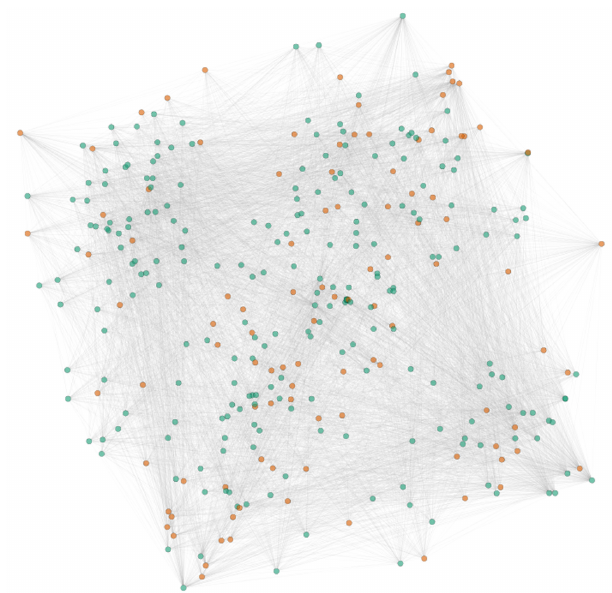
Figure 7. Integrated patient similarity network, generated by combining all networks that consistently pass feature selection. This network is generated by calling plotIntegratedPatientNetwork() and uses RCy3 to programmatically generate the network in Cytoscape 7,8 . This network uses features that scored 2 out of 2 in all train- test splits. For visualization, only the top 8% most-distant edges are shown. Nodes are patients, and edges weights show average similarity across all features passing feature selection. Node fills indicate patient label, with “LumA” in green and “nonLumA” in orange.